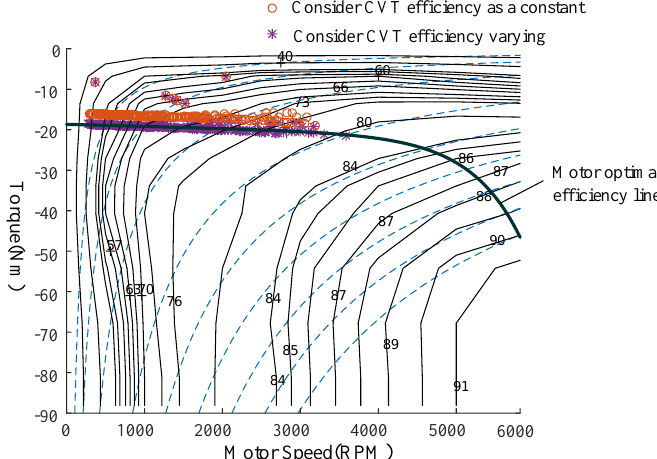
Figure 18. Front motor operating points during regenerative braking under UDDS.